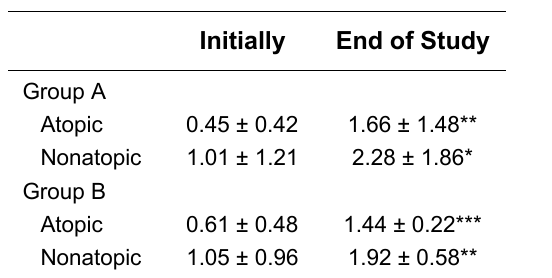
PD , Initially and at the End of the Study 20 when Compared to the Atopic